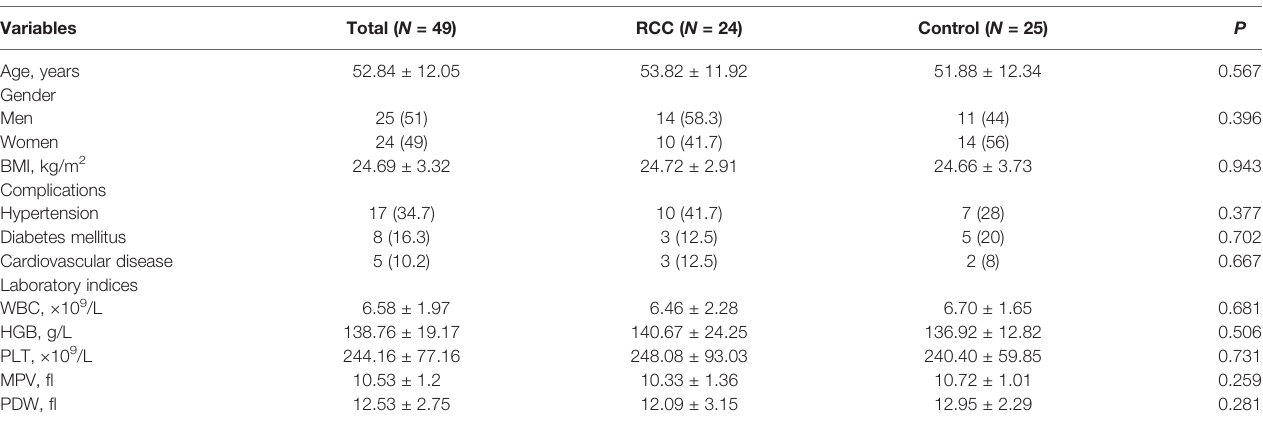
TABLE 1 | The baseline data between the RCC and control groups.